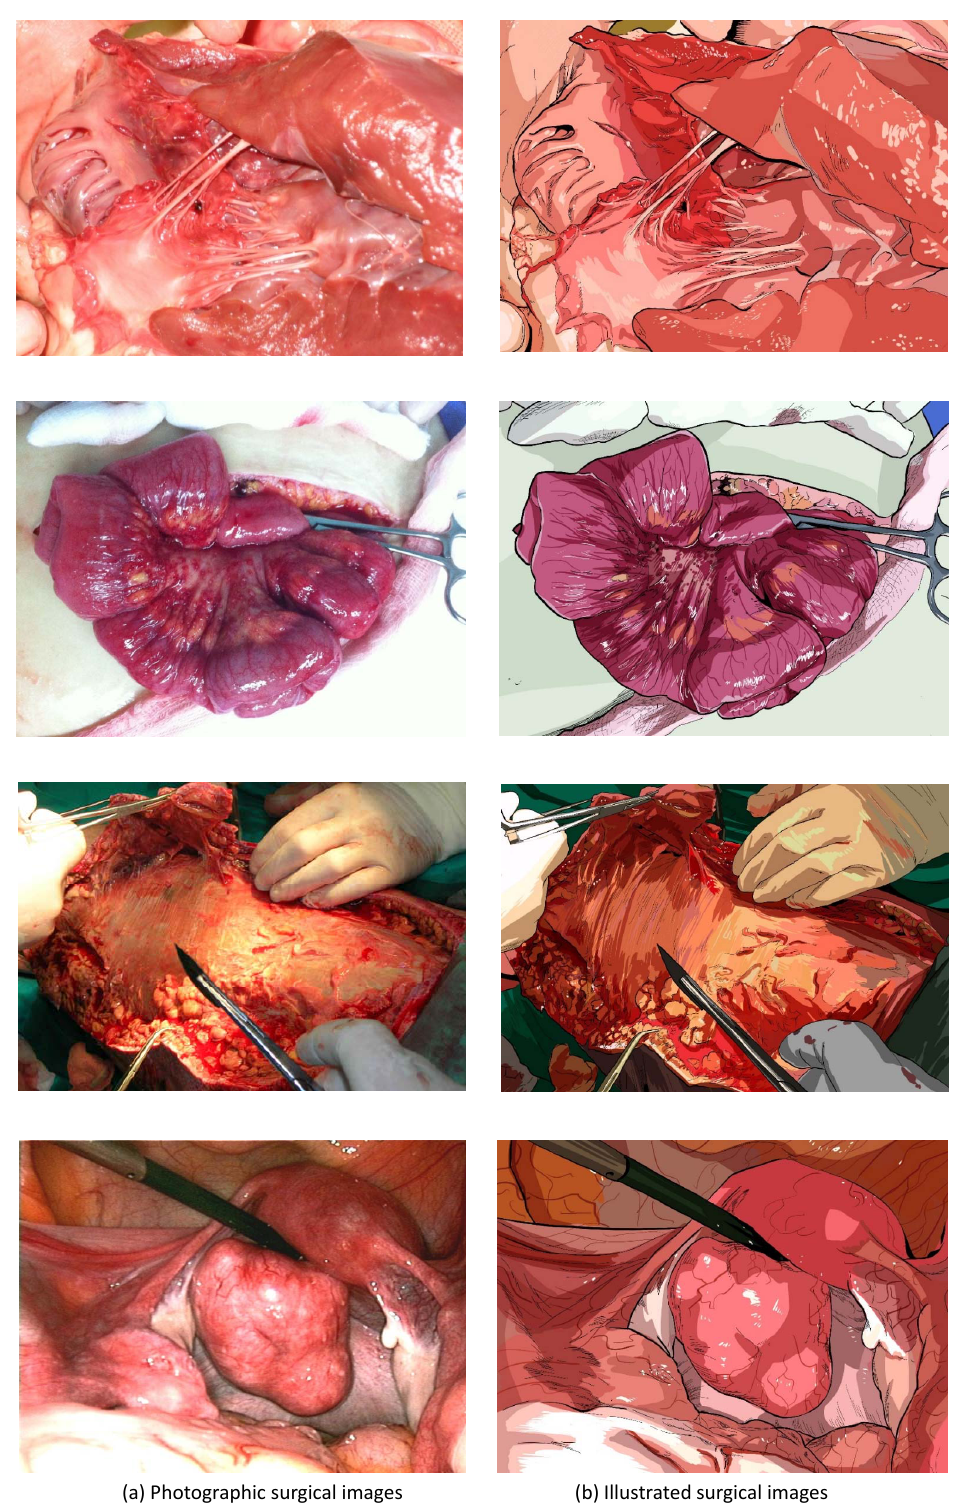
Figure 1. The first comparison of photographic surgical images and illustrated surgical